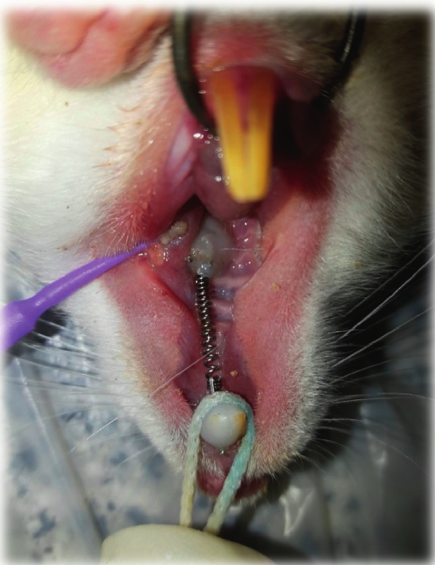
Figure 1: NiTi coil spring placed between the first molar and central incisor of a